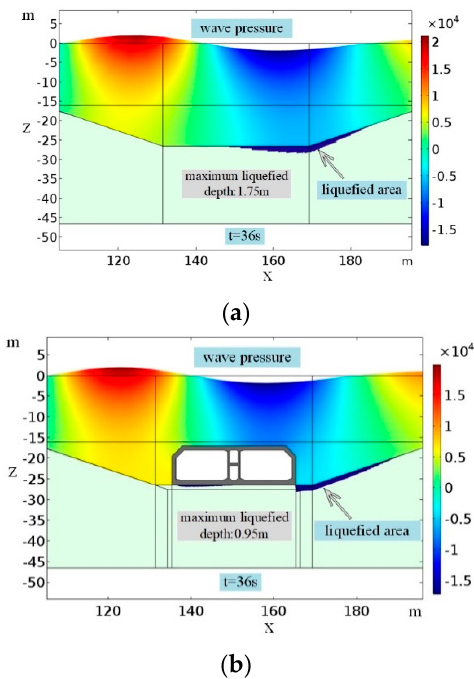
Figure 10. The liquefied area in the trench in two cases: ( a ) after the foundation groove is excavated ( t = 36 s) and ( b ) after the tunnel element is placed ( t = 36 s).